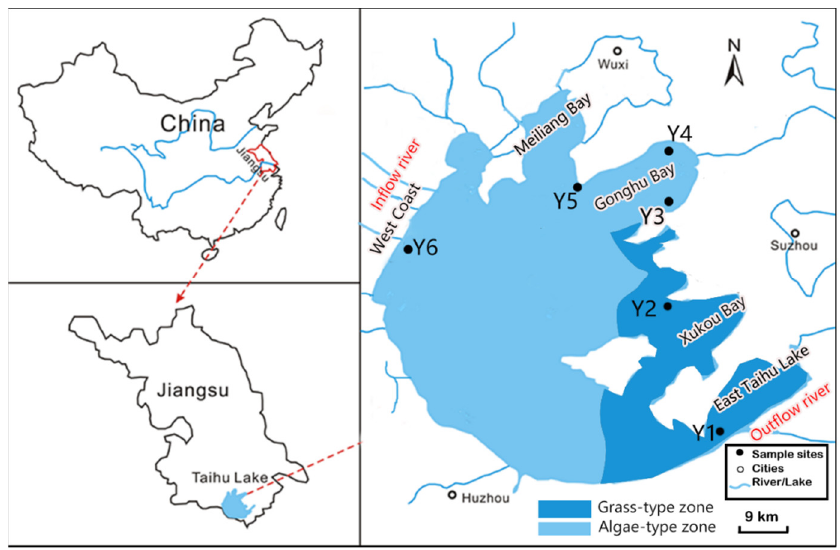
Figure 1. Sampling points in Taihu Lake.